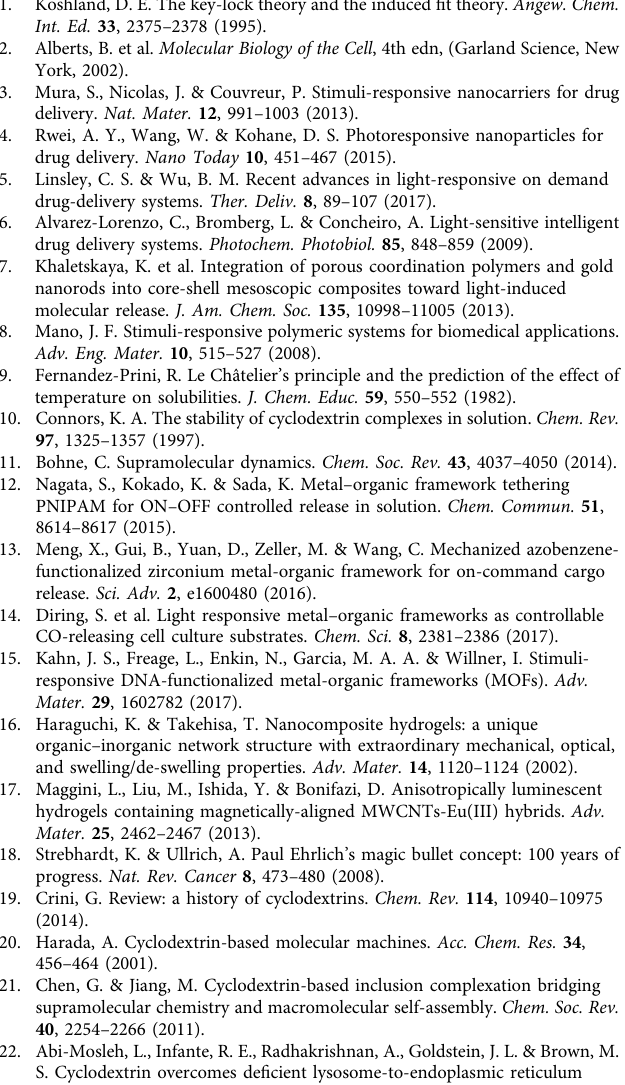
Fig. 6a. The experiment was repeated at least three times to con fi rm our obser- vation. When the solution was cooled and heated with a particular rate, in repeated cycles, Fig. 6b was obtained. When the temperature of the solvent was kept con- stant for a particular time interval (5min) during the cooling or heating process, the ICD signal versus time showed a plateau-like behaviour (Fig. 6c). For the experiments in the hydrogel state, a hydrogel/ Mg-CP / α -CD composite was pre- pared inside a quartz quevette by adding 750 μ L of an aqueous solution of Mg-CP (0.26 mg mL − 1 ) to 750 μ L of an aqueous solution of α -CD (4.33 mgmL − 1 ). To the resulting solution, 1.5mL of 40% stock solution of acrylamide/bisacrylamide was added followed by 300 μ L of 10% ammonium persulphate solution. The resulting mixture was vigorously whisked to prevent the formation of air bubbles. Subse- quently, 50 μ L of tetramethylethylenediamine solution was added to control the rate of the polymerization process. A total of 3mL of the above solution was left undisturbed for ~1 h in a quartz cuvette to obtain a transparent pale yellow hydrogel. The circular dichroism spectral intensities at required constant tem- peratures were measured and plotted against time for monitoring the CD capture – release